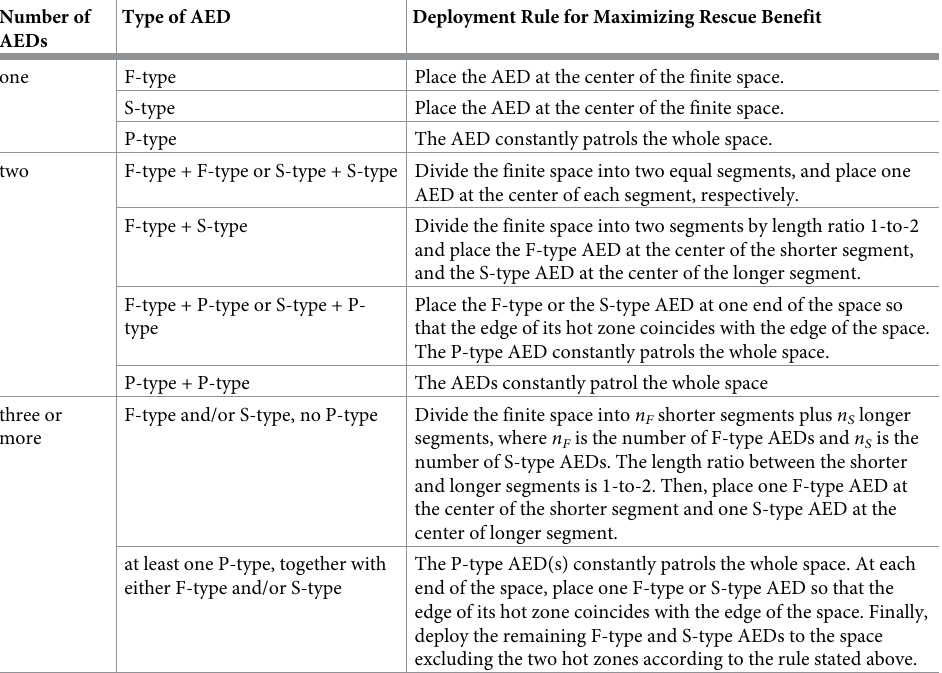
Table 1. Summary of the optimal deployment of one, two, and three or more AEDs in a one-dimensional